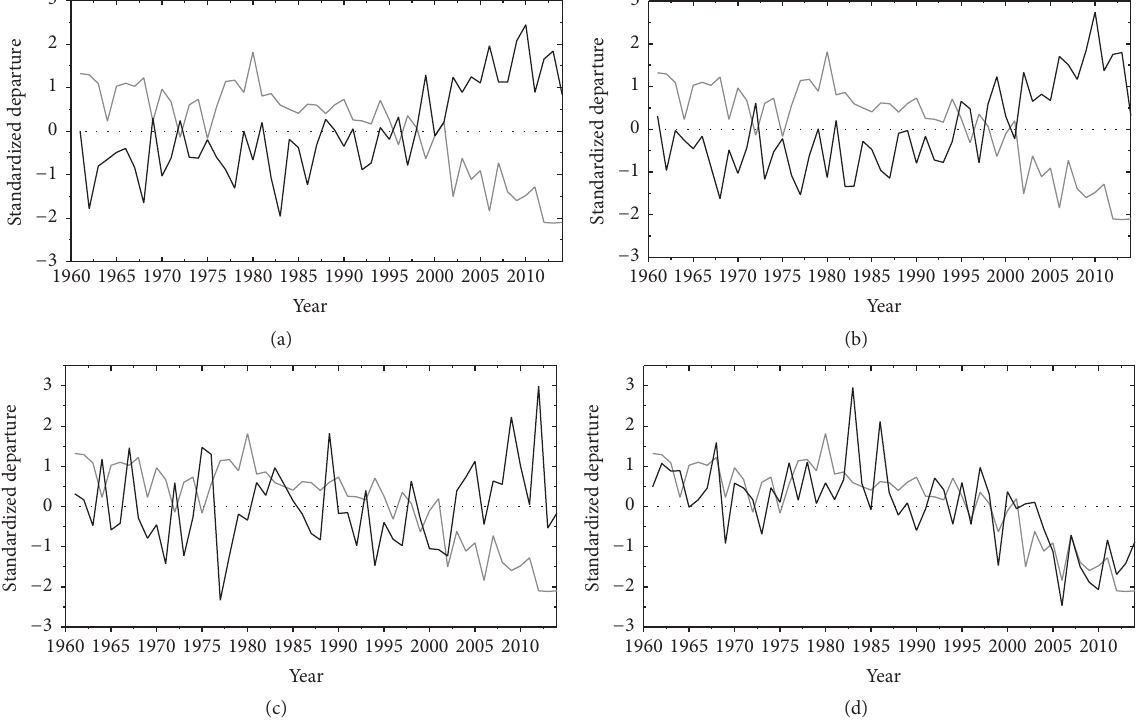
Figure 8: Time series of annual air temperature (a), thawing index (b), annual precipitation (c), and freeze depth (d) in TRSR (black line) with the time series of freeze duration (grey line). All variables were standardized with respect to their mean and standard